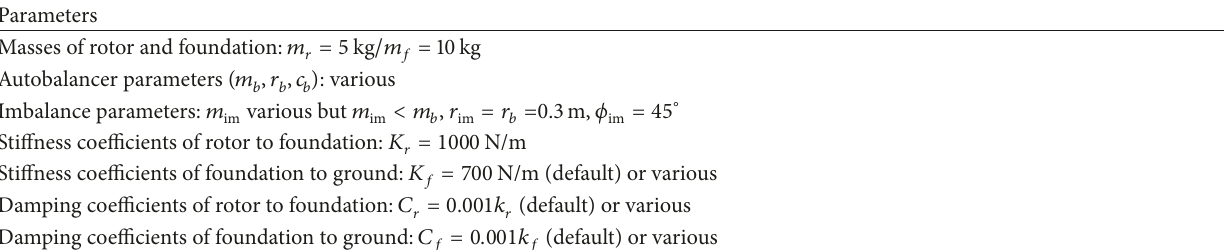
Table 1: System parameters for the numerical simulations.